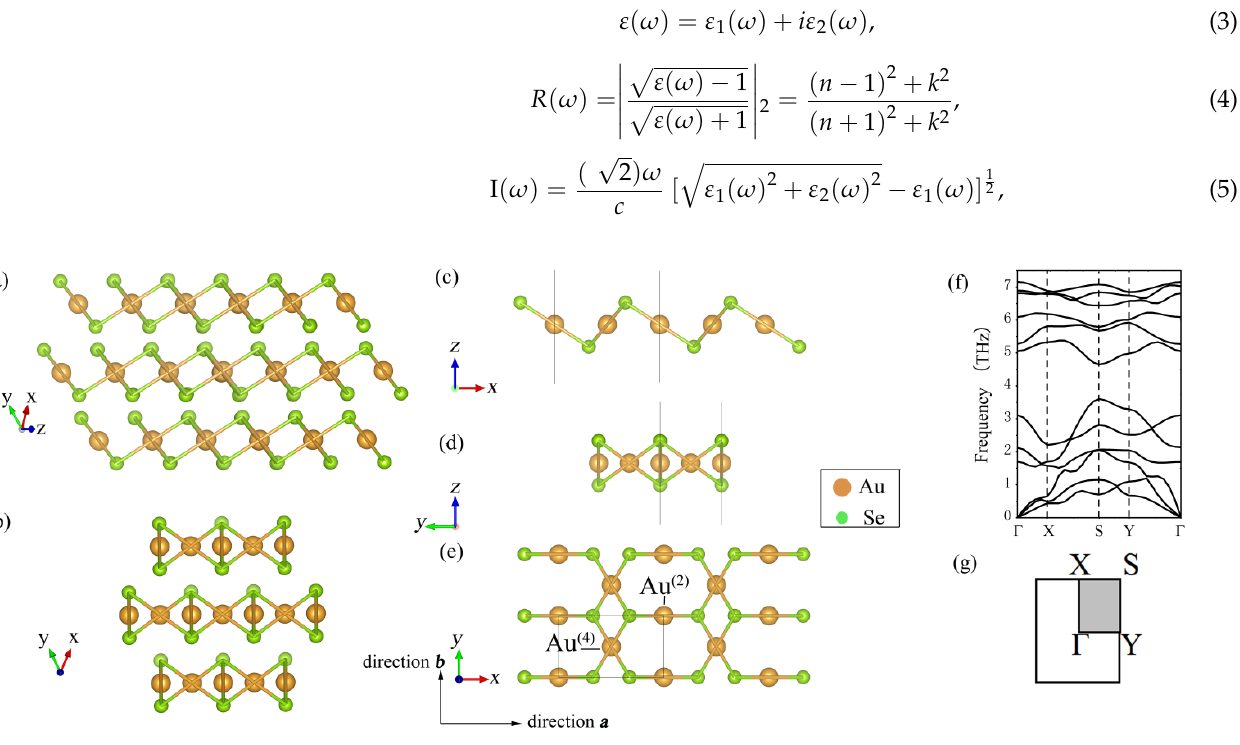
Figure 1. ( a , b ) The crystal structure of the bulk β -AuSe. ( c – e ) The crystal structure of the monolayer β -AuSe. The unit cell is in the black framework. ( f ) The phonon dispersion spectrums for the monolayer β -AuSe. ( g ) The Brillouin zone of the monolayer β -AuSe.